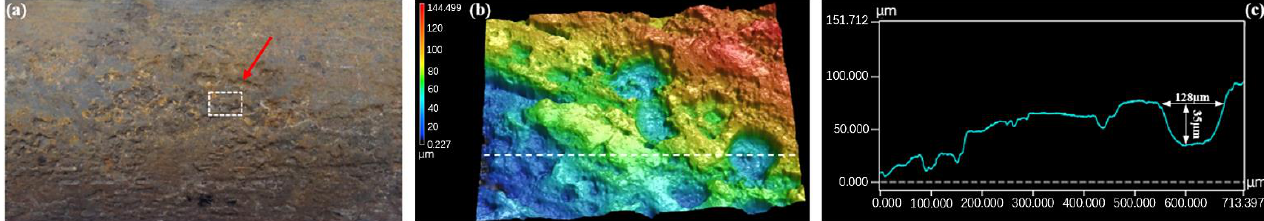
Figure 12. Three-dimensional morphology of the inner wall of tubing after removing corrosion products. ( a ): Sampling location; ( b ): 3D morphology; ( c ): pitting depth.